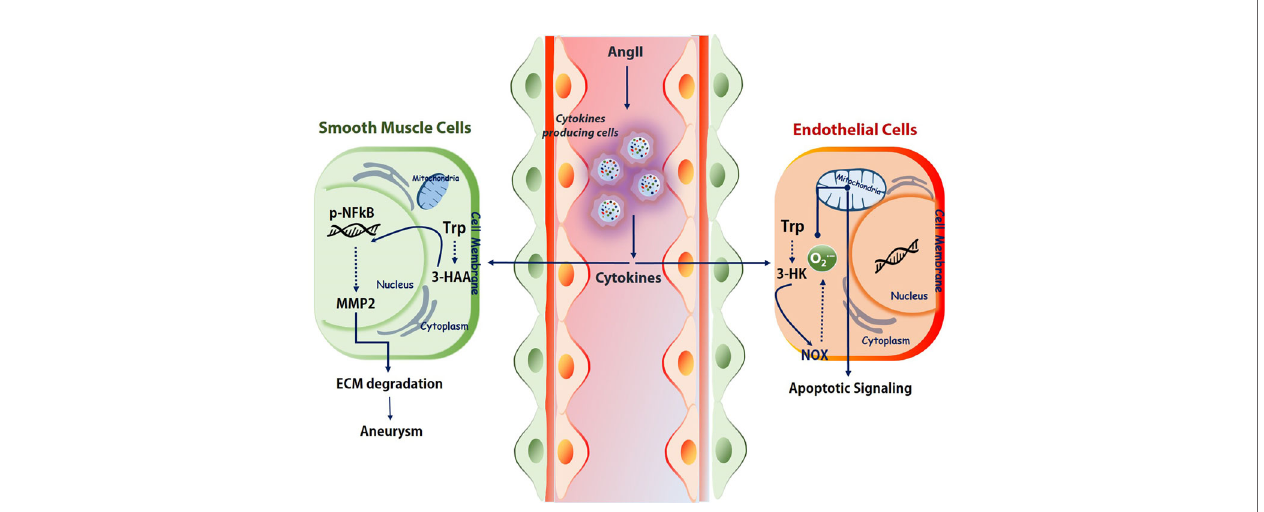
FIGURE 2 | Kynurenines association to vascular diseases. Immune cells under challenged conditions release various cytokines (IFN g , TGF- b , etc.) to regulate the activation and expression of the kynurenine pathway. Depends on the cell types and milieu, the activated KP effects differently. For example, in SMCs, 3-HAA triggers NF- k B and MMPs, which further degrades ECM. In endothelial cells, tryptophan catabolite 3-HK activates the NOX and produces superoxide. This superoxide further shoots up the apoptotic signaling. Trp, tryptophan; 3-HAA, 3-hydroxyanthranilic acid; AngII, angiotensin II; ECM, extracellular matrix; NOX, NADPH oxidase.